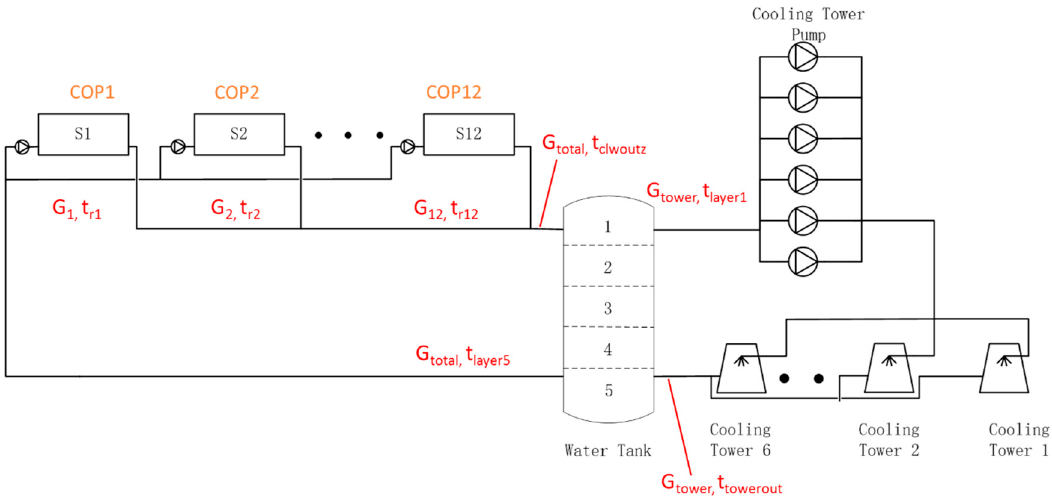
Figure 2. Schematic diagram of distributed variable-frequency pump (DVFP) and water storage (WS) system.